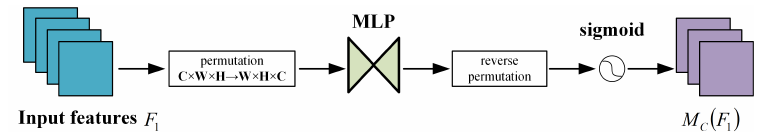
Figure 6. Channel attention submodule.